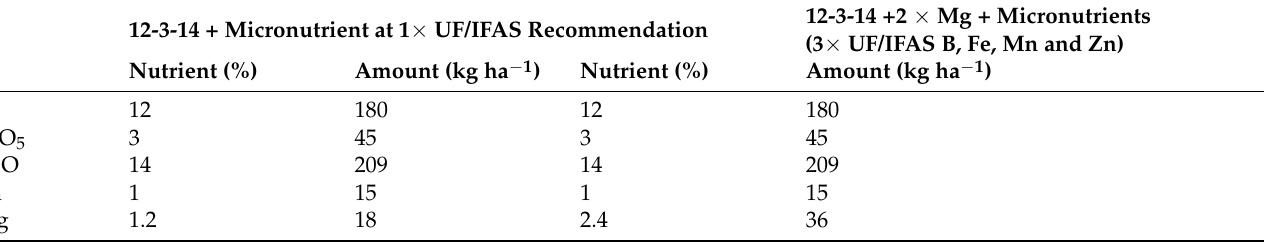
Table 11. Controlled-release fertilizer